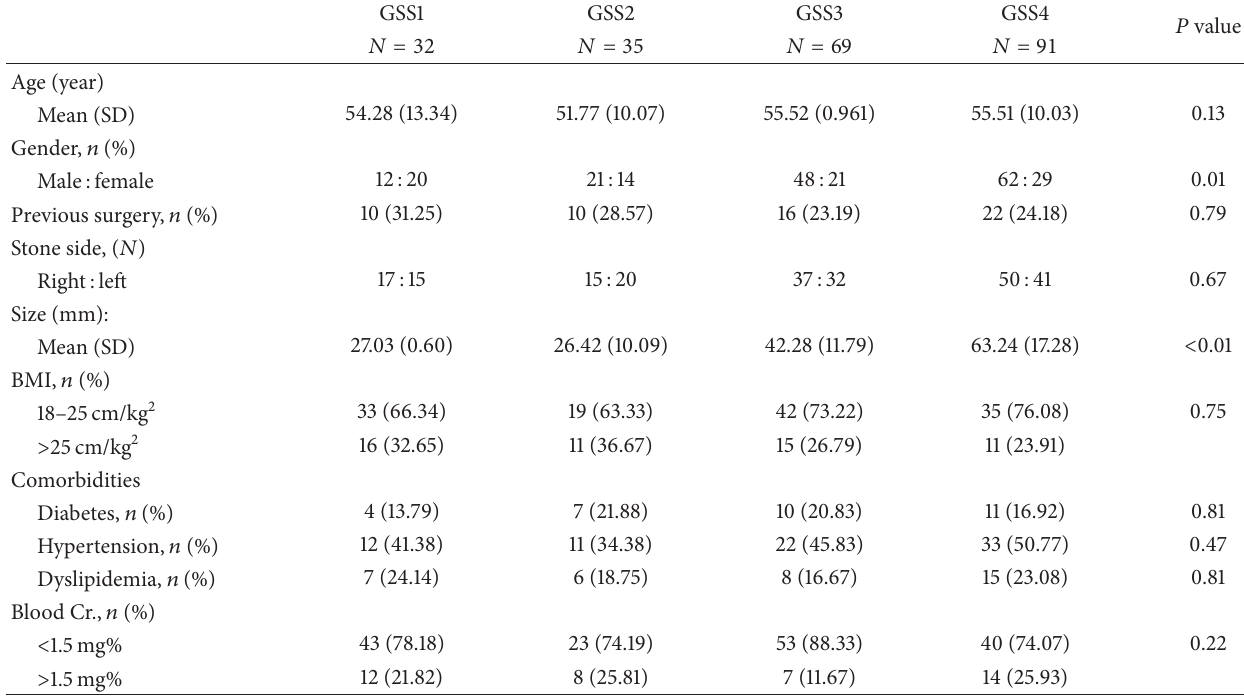
Table 1: The demographic data of total upper pole access patients ( 𝑁 = 227 ).